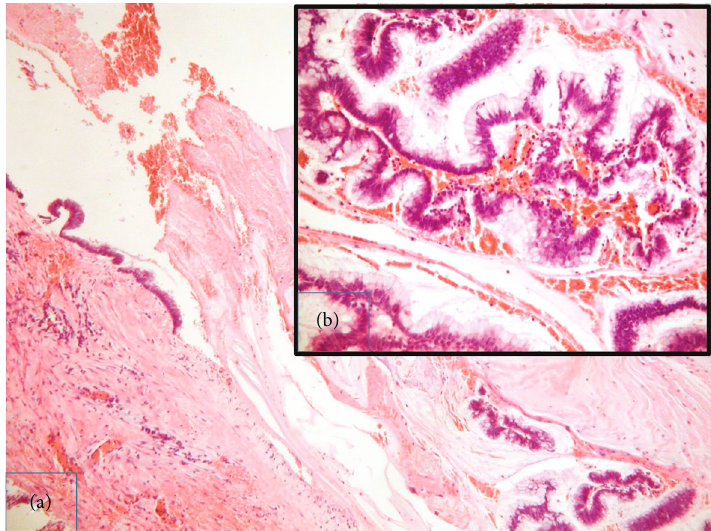
Figure 3: (a) Histopathology of low-grade mucinous neoplasm of the appendix characterized by fl at mucinous epithelial proliferation replacing the mucosa and fi brosis of the wall. H/E × 400. (b) Mucin-producing columnar glandular epithelium with low-grade dysplasia H/E ×